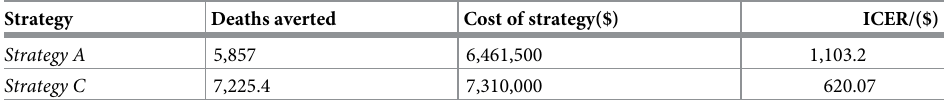
Table 10. Comparison between ICER of strategies A and C. Strategy